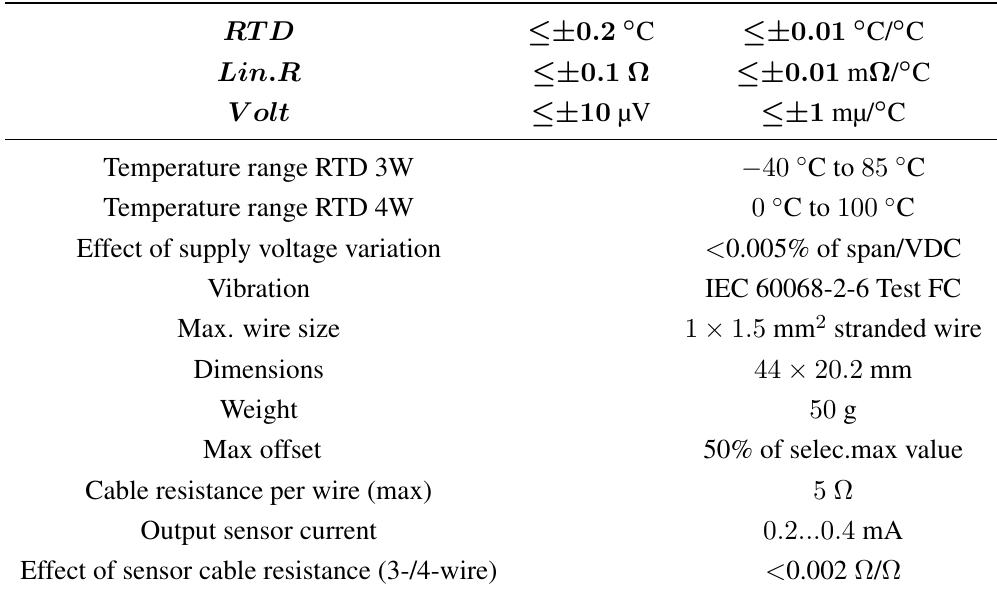
Table 1. RTDPt-100